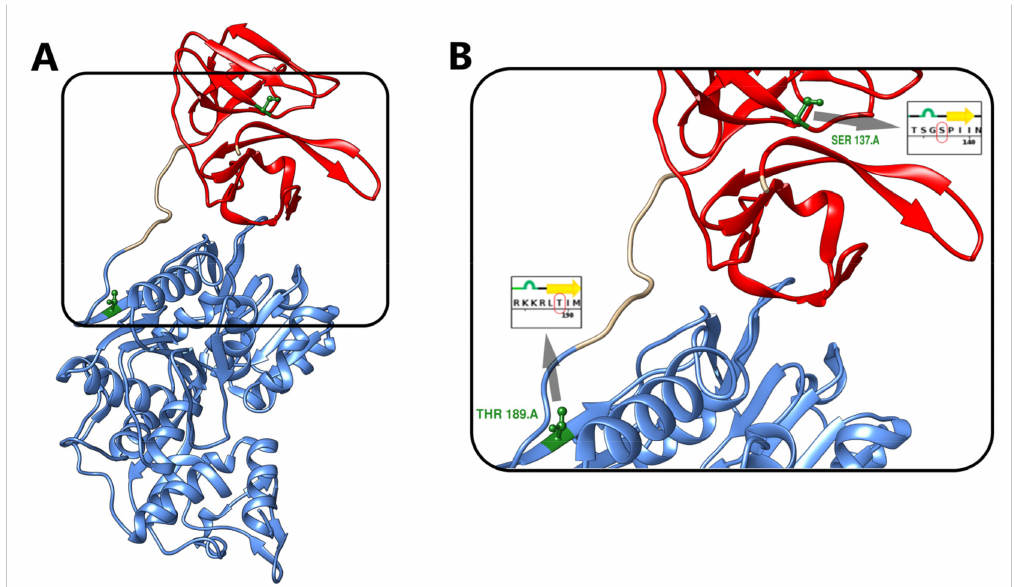
Figure 1. NS3 crystal structure. ( A ) The crystal structure of the NS3 Protease-Helicase from Dengue virus (PDB: 2VBC). The Protease domain (N-terminal, residues 20–168) is shown in red. The linker (169–179 is uncolored. The Helicase domain (C-terminal, NS3Hel, residues 180–618) is shown in blue. ( B ) Serine 137 residue (S137) and Threonine 189 residue (T189) location in NS3 conformation and its position in the amino acid sequence (inset-circled in